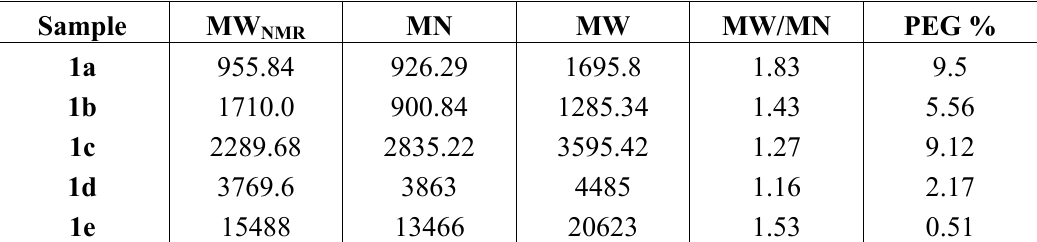
Table 1: Molecular weights of triblock copolymers